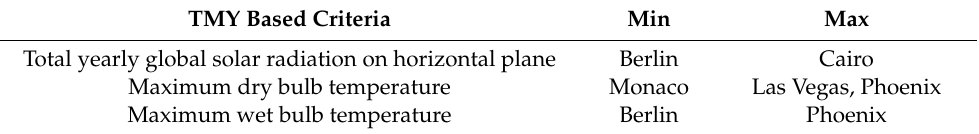
Table 2. Locations with minimum and maximum values of climatic parameters.